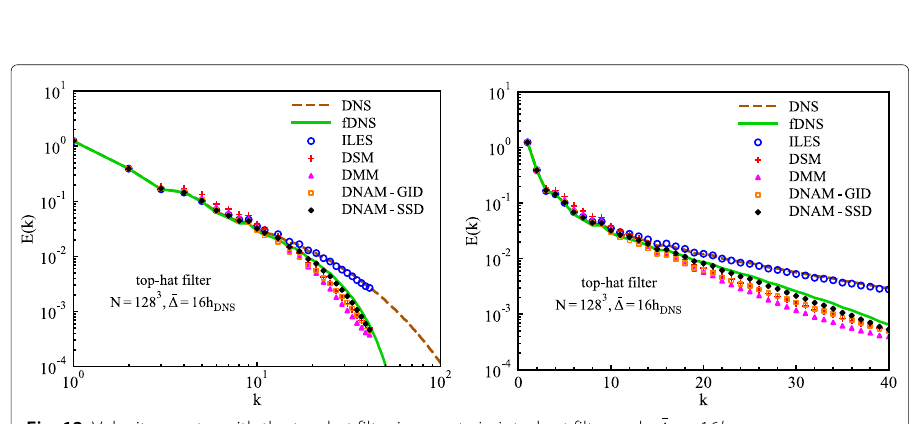
Fig. 12 Velocity spectra with the top-hat filter in aposteriori study at filter